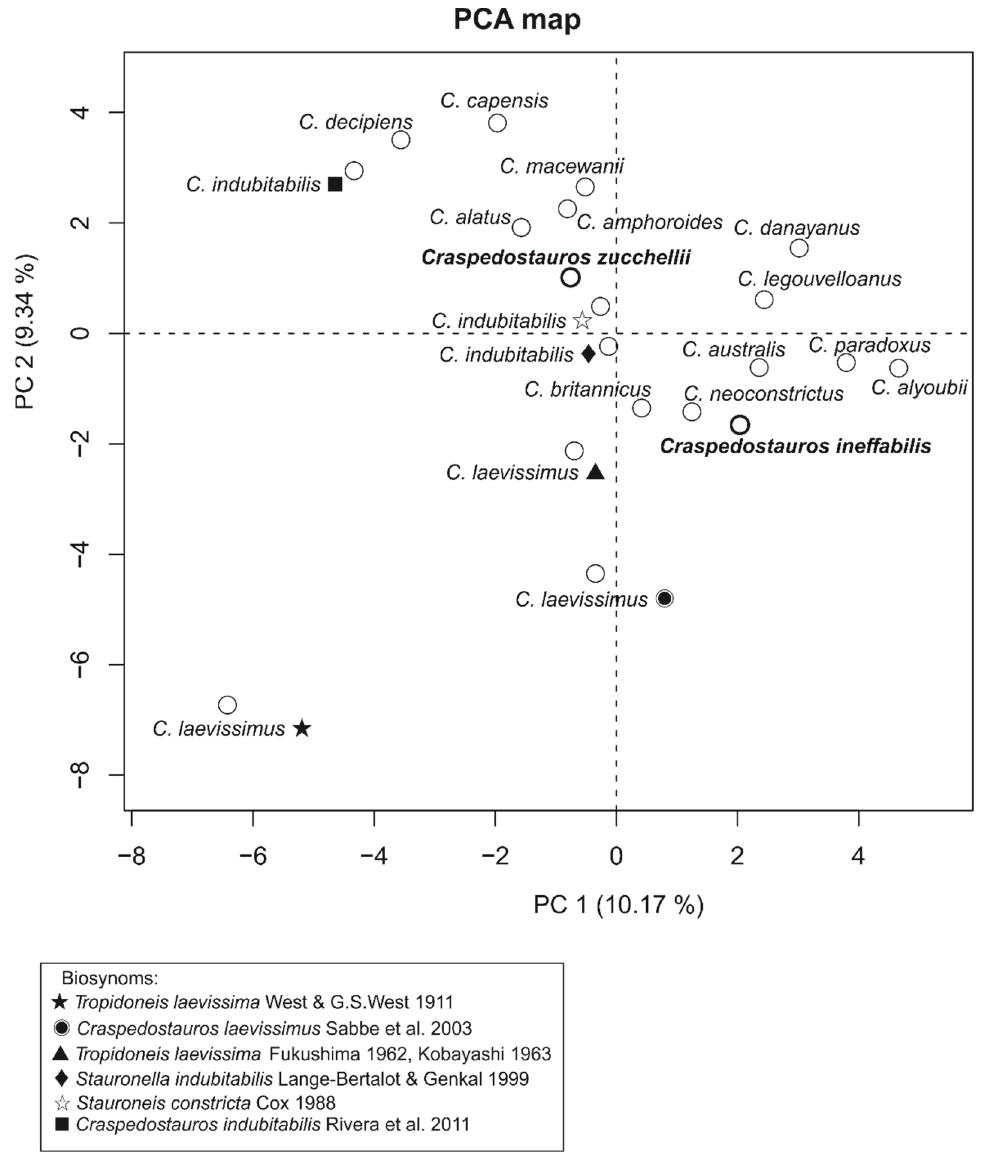
Figure 5. Principal component map showing morphological and ecological dissimilarities between Craspedostauros species [46–51,53].